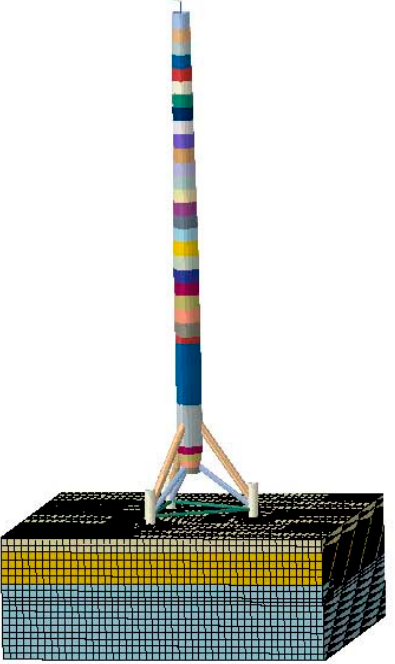
Figure 6. Finite element model of offshore wind turbine by Abaqus.